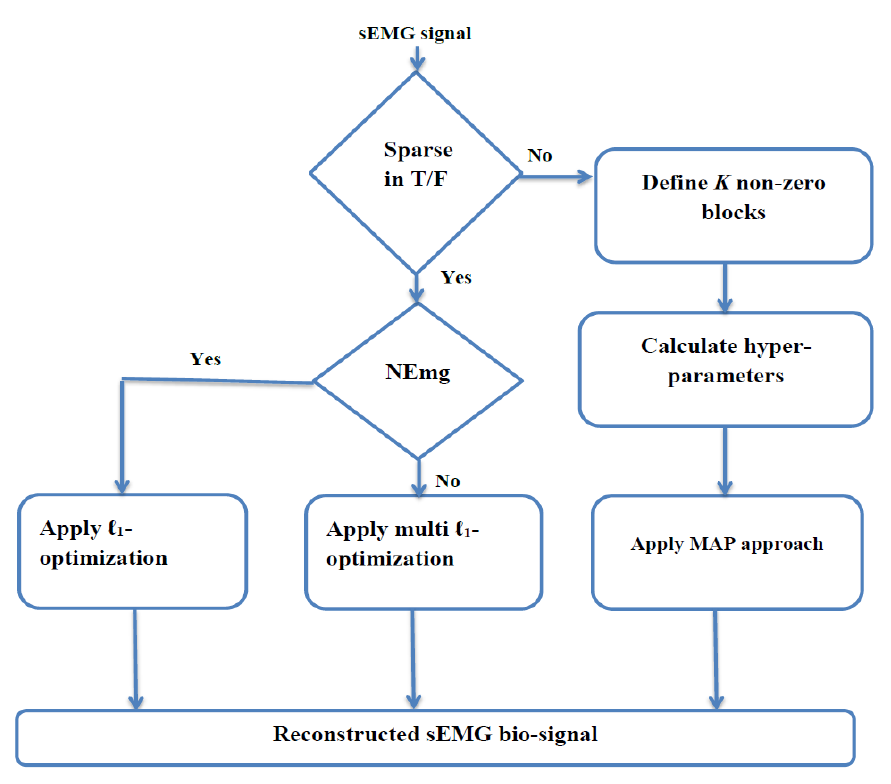
Figure 4. Flowchart for Algorithm